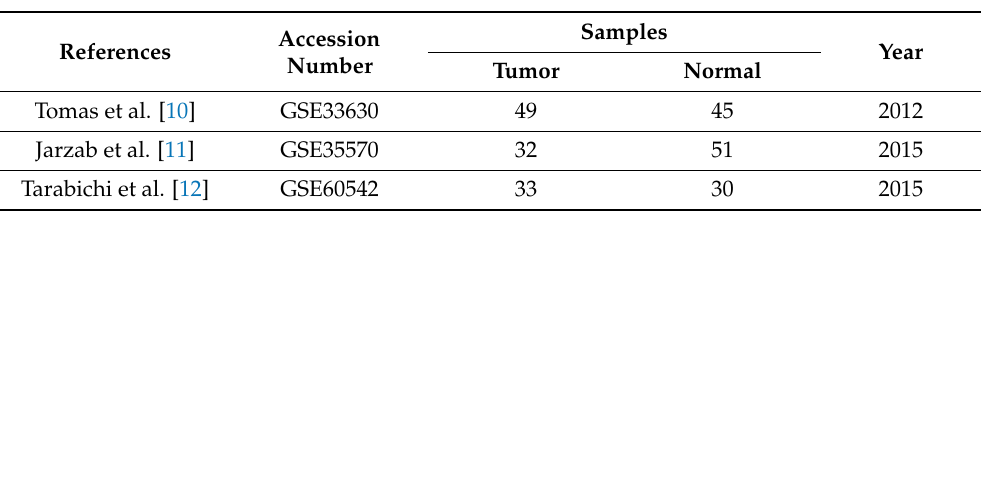
Table 1. The information of datasets from the GEO